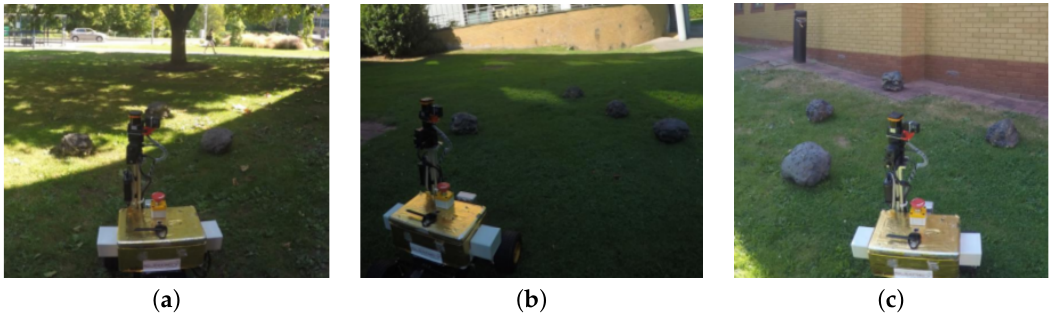
Figure 19. The test sites chosen for performing the experimental analysis; Site A ( a ), Site B ( b ) and Site C ( c